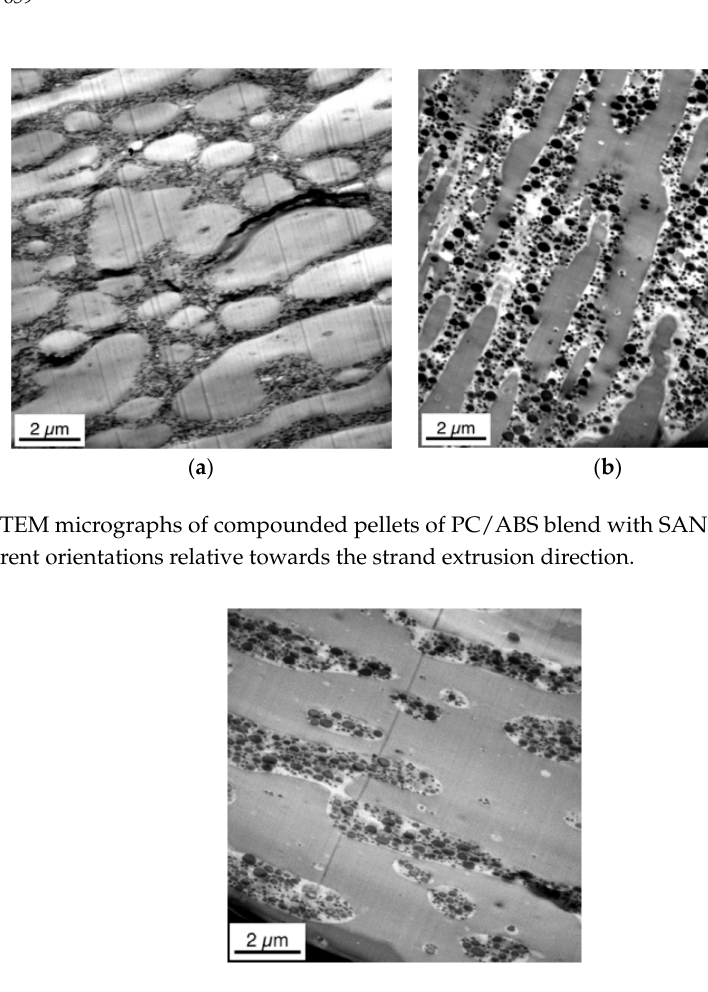
Figure 7. TEM micrograph of compression-molded sample of PC/ABS blend with SAN medium cut from the middle of the specimen.